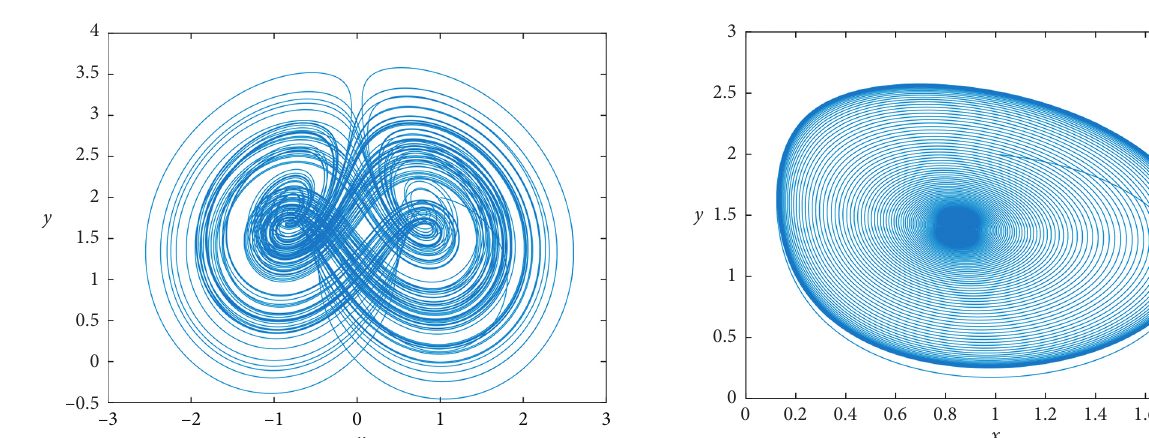
Figure 18: Dynamic behavior of fractional financial chaotic model with α � 0 . 95.